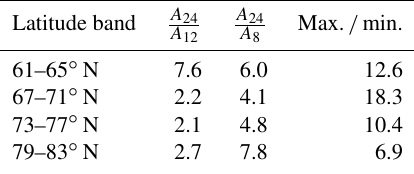
Table 4. Ratios of IWC tidal amplitudes for July 2009 and different latitude bands. No threshold has been applied, IWC values of zero (no PMCs) are included. The ratios of maximum to minimum IWC indicate the variability throughout the day. For details see